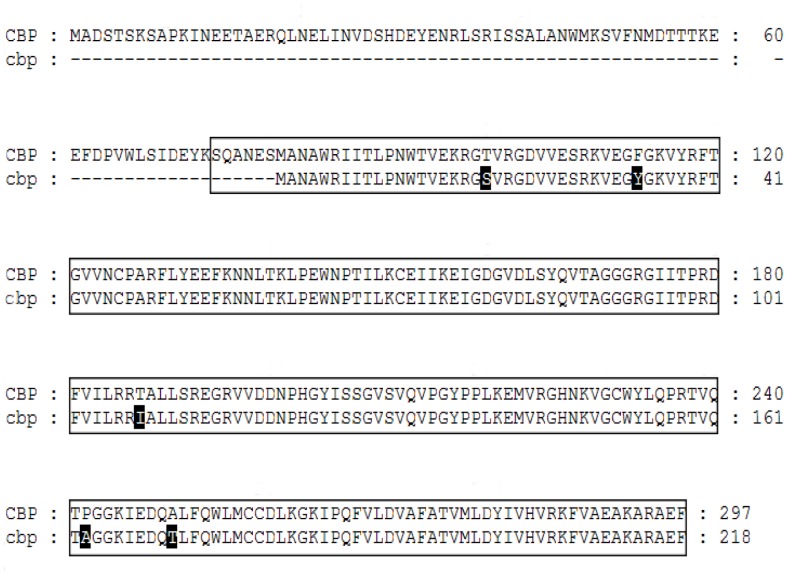
Protein Sequence Comparison Between CBP and cbp.There was an absence of 79 amino acids on the N-terminal of cbp compared to CBP. The boxed area represents the region of steroidogenic acute regulatory protein (StAR)-related lipid transfer (START) domain. The black highlight areas indicate mutation of amino acids residues in cbp compared to CBP.